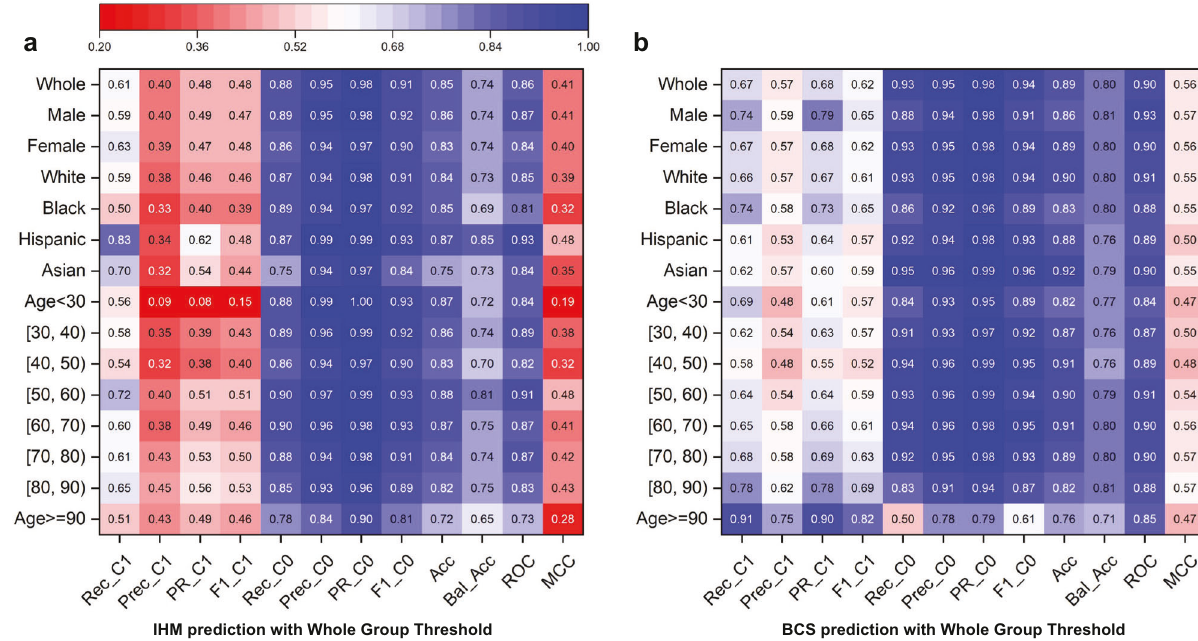
Fig. 3 Prediction results under the original machine learning models (no bias correction) using one optimized threshold for all demographic groups. Rec_C1, Prec_C1, PR_C1, F1_C1, Rec_C0, Prec_C0, PR_C0, F1_C0, Acc, Bal_Acc, ROC, MCC stand for Recall Class 1, Precision Class 1, Area Under the Precision-Recall Curve Class 1, F1 score Class 1, Recall Class 0, Precision Class 0, Area Under the Precision-Recall Curve Class 0, F1 score Class 0, Accuracy, Balanced Accuracy, Area under the ROC Curve, Matthews Correlation Coef fi cient (MCC), respectively. a Prediction results for the IHM prediction. Class 1, representing death after staying 48 h in intensive care units at the hospital, is the minority prediction class. Class 0, representing survival after staying 48 h in intensive care units, is the majority prediction class. b Prediction results for the BCS prediction. Class 1, representing death